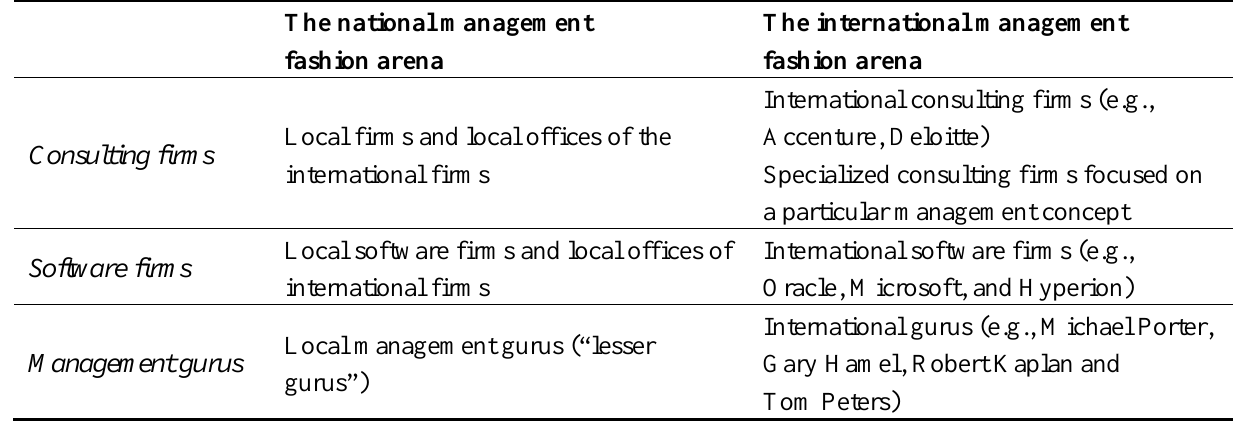
Table 2. Local and international actors involved in management fashion